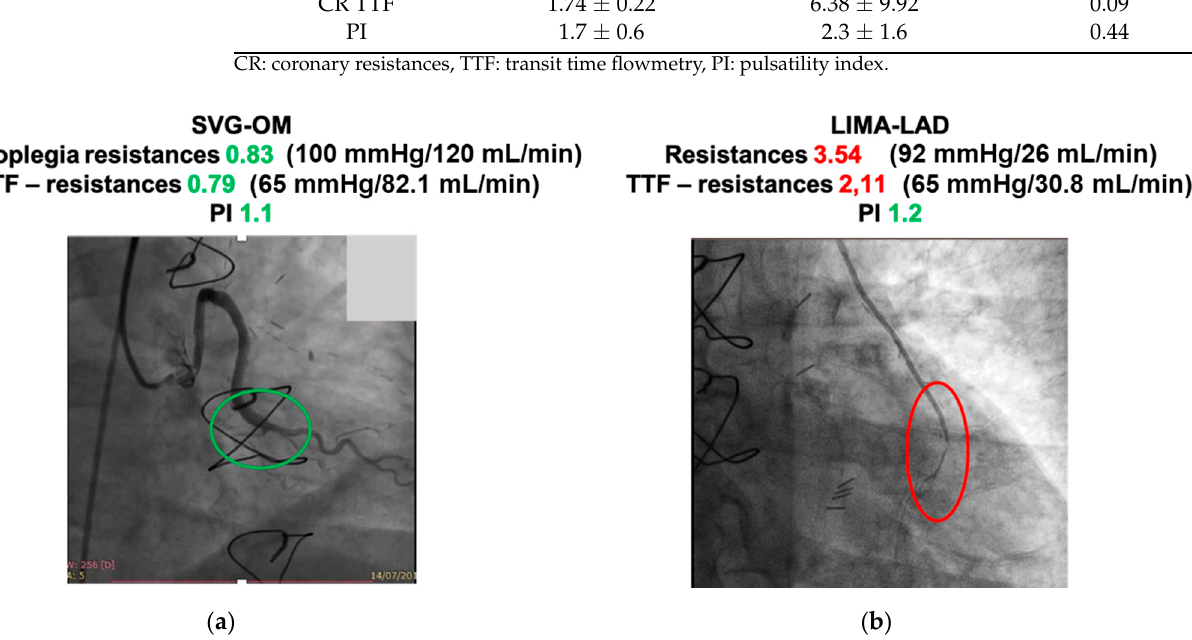
Table 4. Univariate logistic regression model to predict graft occlusion.